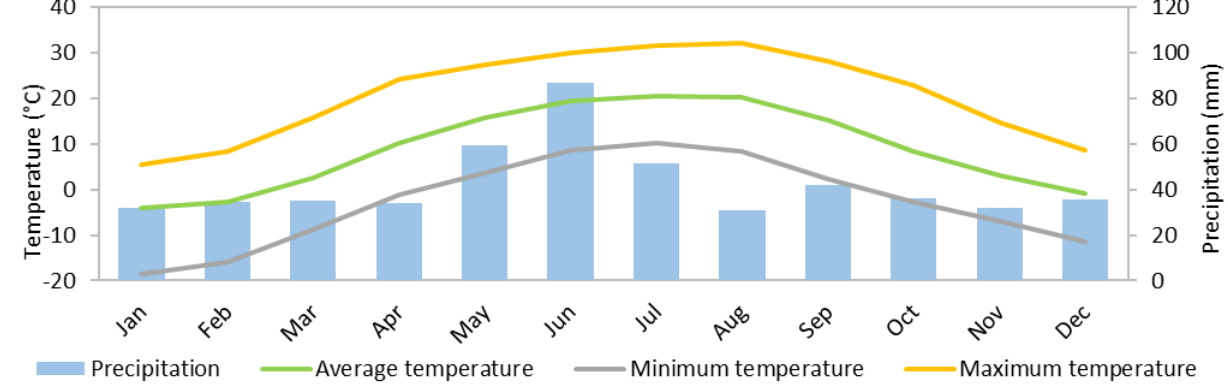
Figure A2. Average monthly climatic conditions of the study site located in Spain during the study period 2009 – 2018.